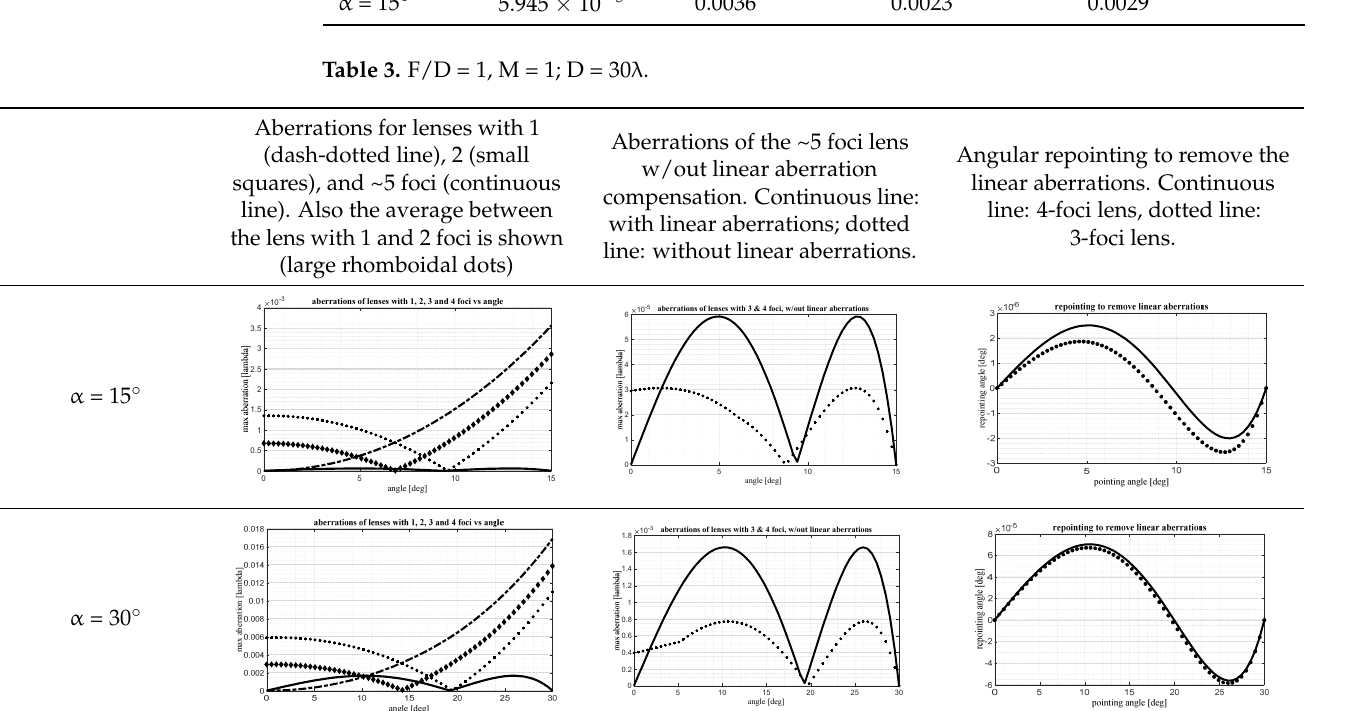
Table 4. Maximum aberrations normalized to the focal distance for discrete lenses having F/D = 1, M = 1 and ∼ 5 foci. α = 60°